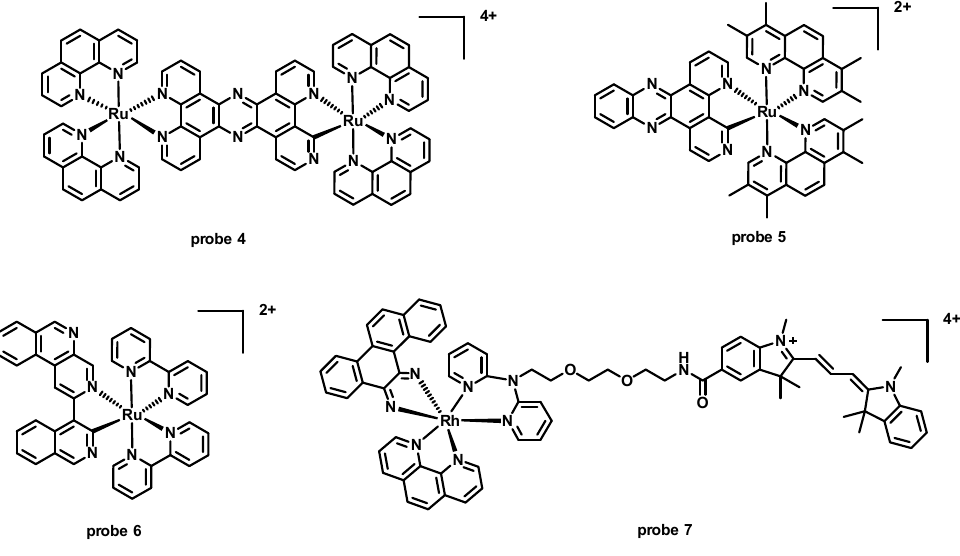
Figure 10. Structures of probe 4–7. Carbon dots are a new class of fluorescent nanomaterials that have gained increasing popularity over the past decade due to their unique optical properties, good biocompati- bility, low toxicity, great aqueous stability, etc. [41,42]. Serdiuk and coworkers developed a fluorescent probe based on SiC nanoparticles [43]. Studies have found that cell division (or proliferation) plays a key role for the cellular uptake and nuclear targeting of probes. Regrettably, the relationship between cell division and SiC NP nuclear uptake is unclear. In 2019, Zhang et al. reported a cationic carbon quantum dot (cQD) probe that binds to dsDNA and ssRNA in living cells in different ways, emitting green and red fluorescence in the nucleus and nucleolus, respectively, and can be used to simultaneously image two types of genetic materials (Figure 11a) [44]. The dsDNA molecules with high structural rigidity confine the cQDs into the grooves, thereby enhancing the fluorescence of the isolated particles, while the flexible ssRNA acts as a cQDs collector, effectively clustering the cQDs so that they emit red fluorescence (Figure 11b,c). In addition, this cQD probe possesses great photostability and biological barrier permeation ability.